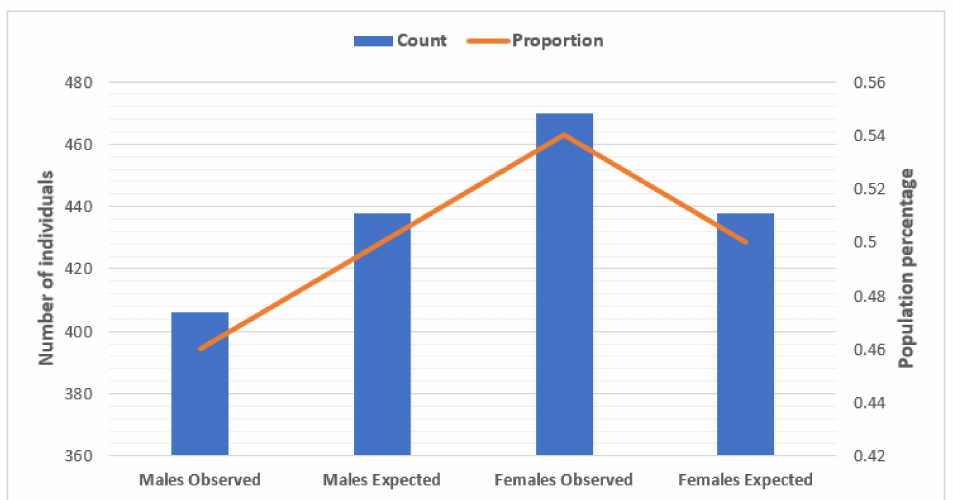
Figure 9. Results of the chi-square goodness-of-fit test of observed and expected overall sex ratio and their proportion.